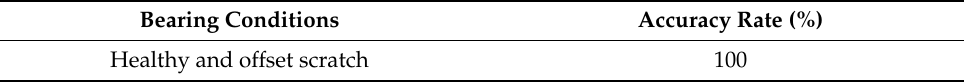
Table 4. Diagnostic results of offset